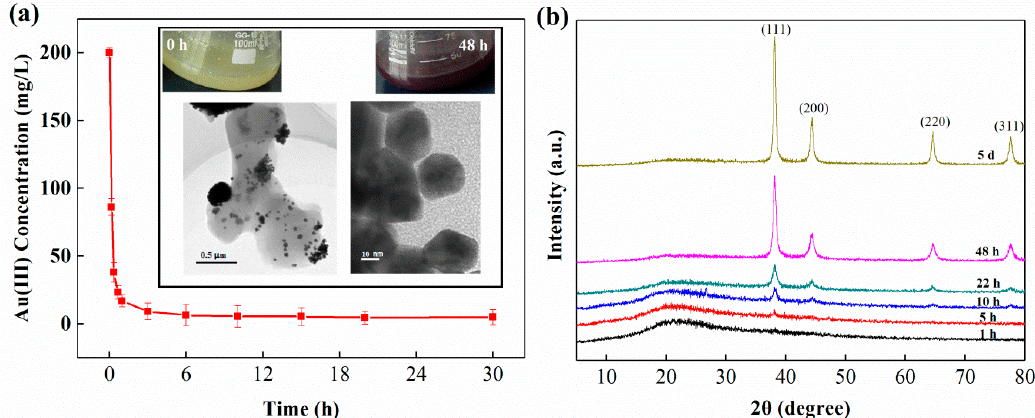
Figure 1. The interaction between bacteria and Au(III) with time. ( a ) The Au(III) concentration in aqueous solution. The inserts show the color of the culture (top) at 0 h and 48 h, respectively; and TEM images of cells and Au particles (bottom) at 48 h. ( b ) XRD pattern of the AuNPs enhanced over time.